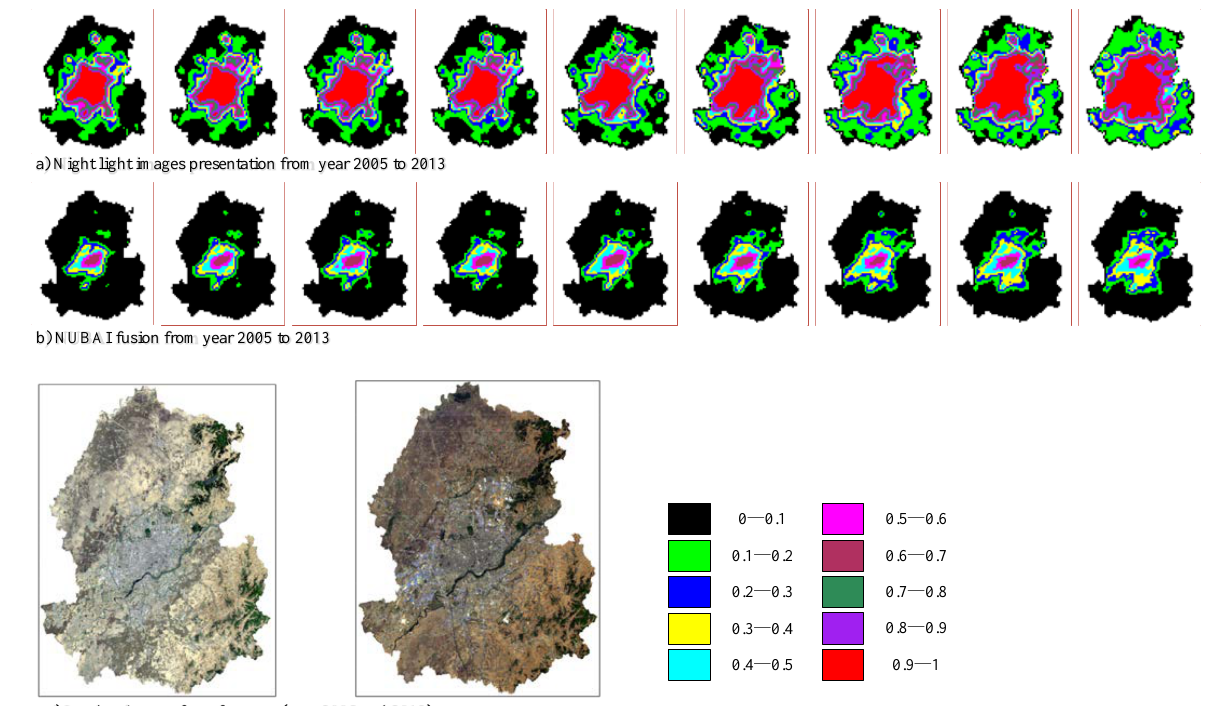
Figure 3. Image fusion results. ( a ) Night light images; ( b ) NUBAI fusion results; ( c ) Landsat images for reference. Values in the night light images and NUBAI were between 0 and 1.